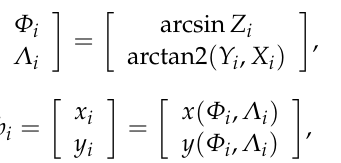
Figure 4. Two-dimensional points and vectors on the projection plane under the different conditions of α . ( a ) α ≥ 0; ( b ) α <